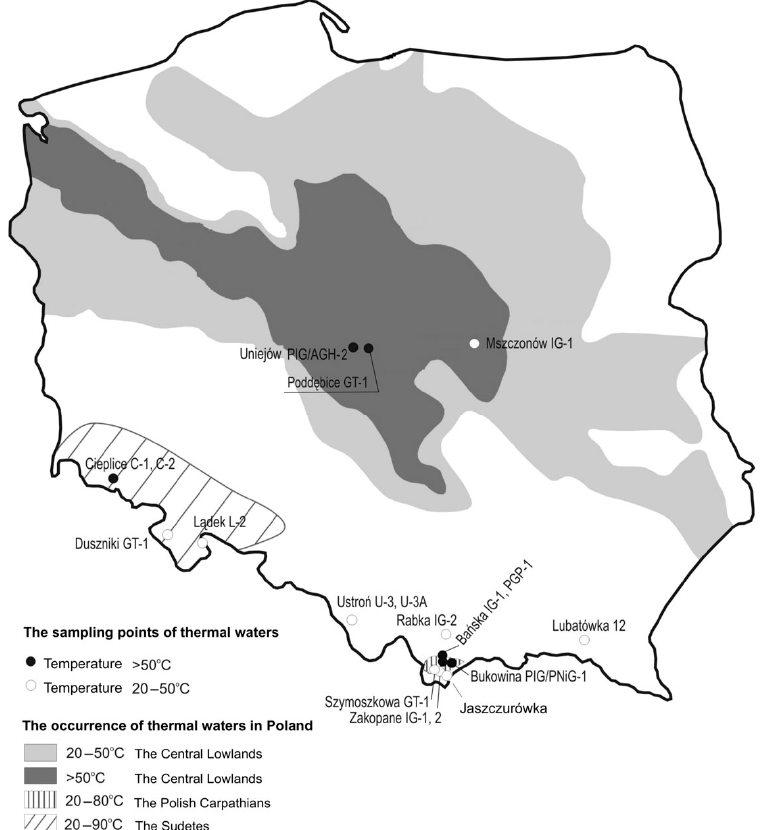
Figure 1. Map of sampling sites of selected thermal